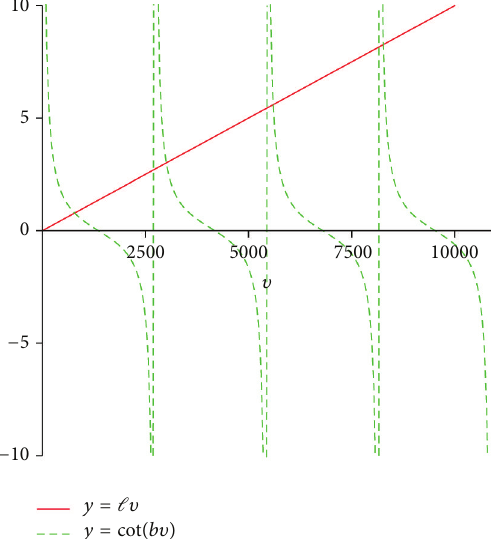
Figure 2: Infinite number of solutions of the two functions 𝑦 = ℓ𝜐 and 𝑦 = cot (𝑏𝜐)